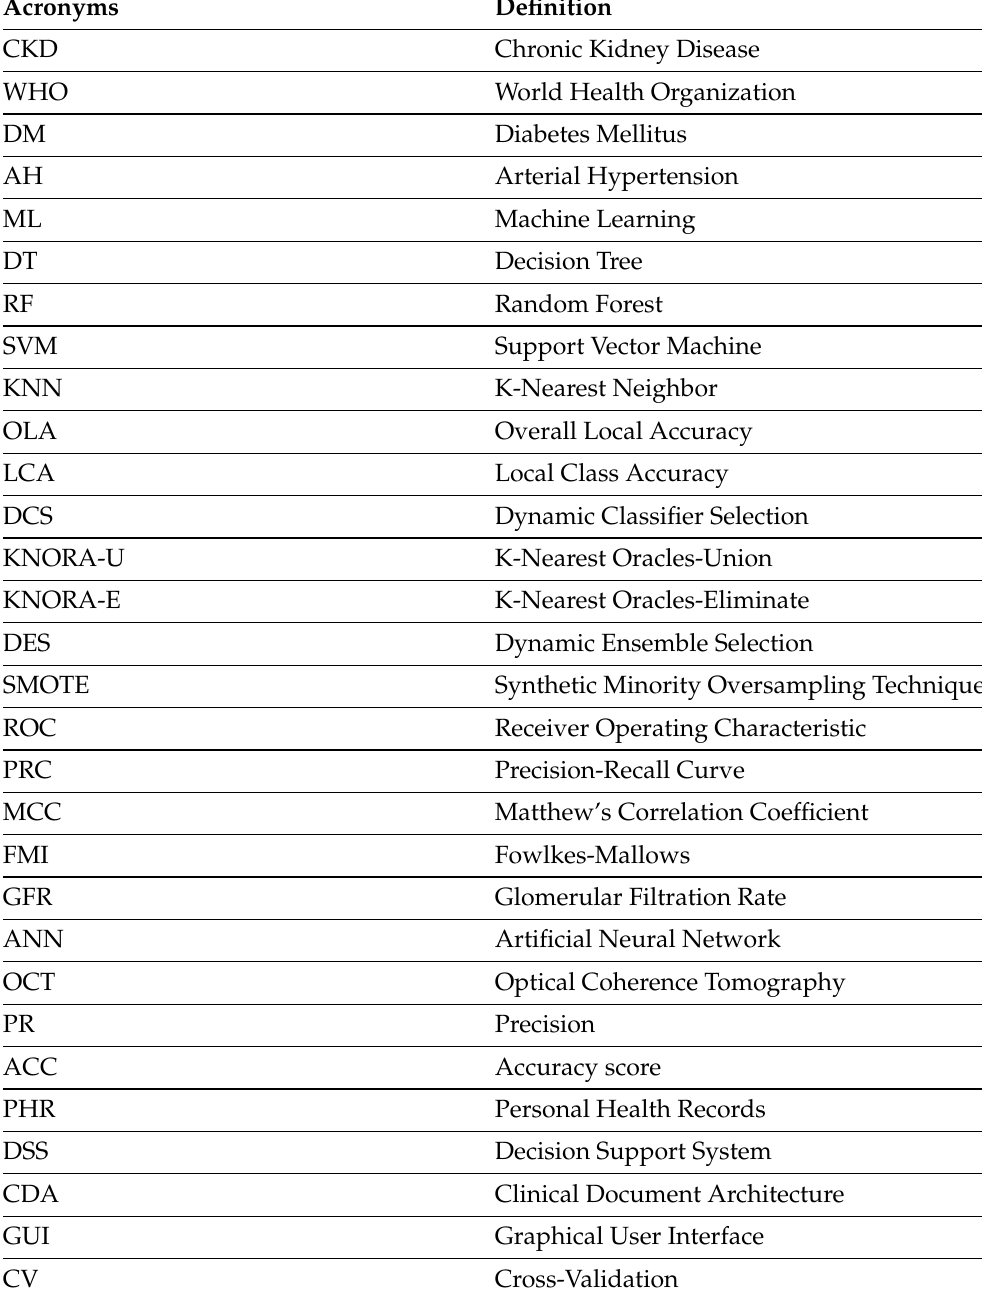
Table 1. Summary of main